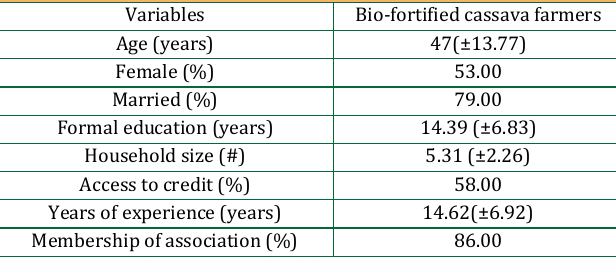
Table 2: Socio-economic Characteristics of Bio-fortified Vit-A Cassava